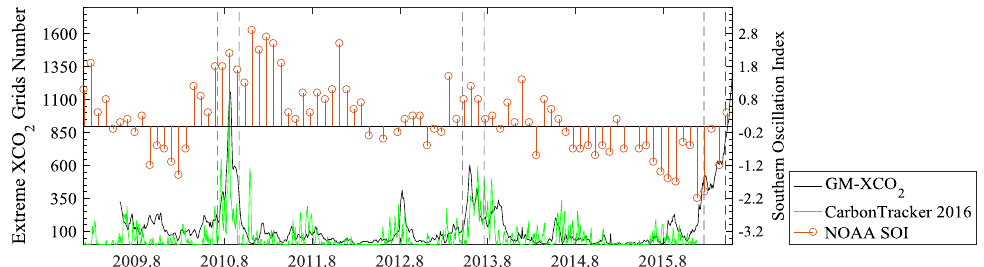
Figure 6. Southern Oscillation Index is shown in the top panel. Time series statistics of extreme XCO 2 grid number of retrievals from GOSAT (black) and CarbonTracker (green) are shown in the bottom.